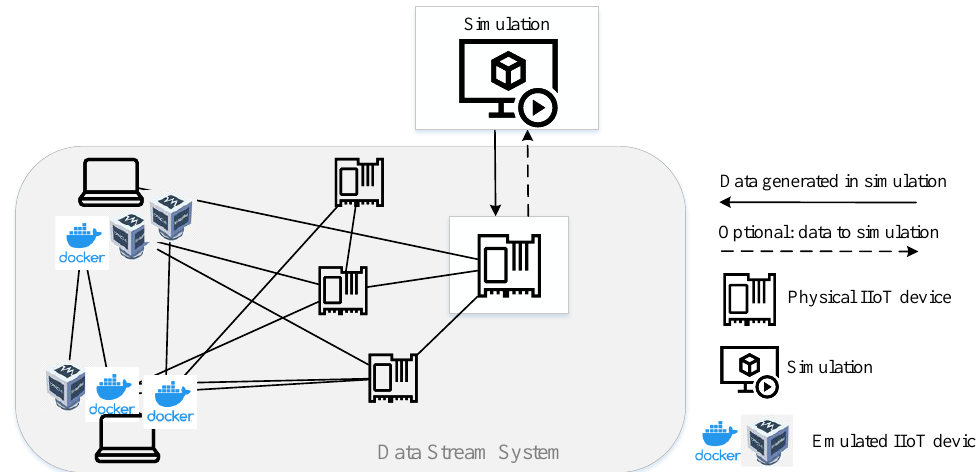
Figure 5. Architecture 1: one device coupled with a simulation and connected to a further network.